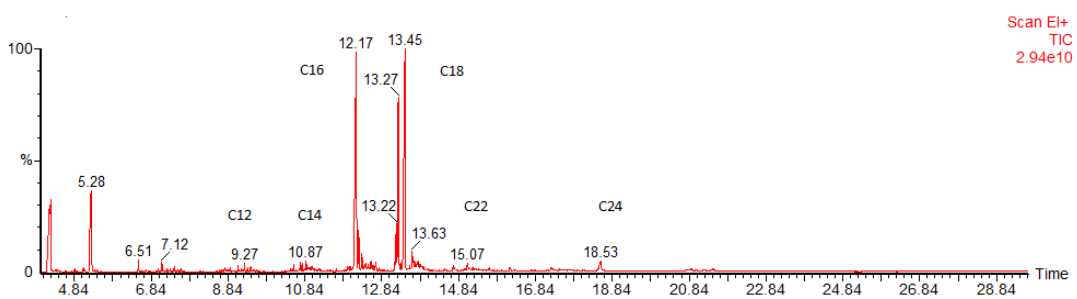
Figure 3. GC–MS profile of methyl esters of free FAs from C. subglobosa .